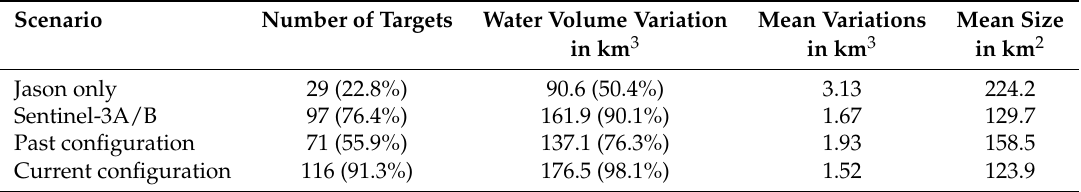
Table 3. Water storage changes from WGHM that are mapped by different altimetry constellations. The values in parentheses are the percentages of the total number and total volume variations from WGHM,